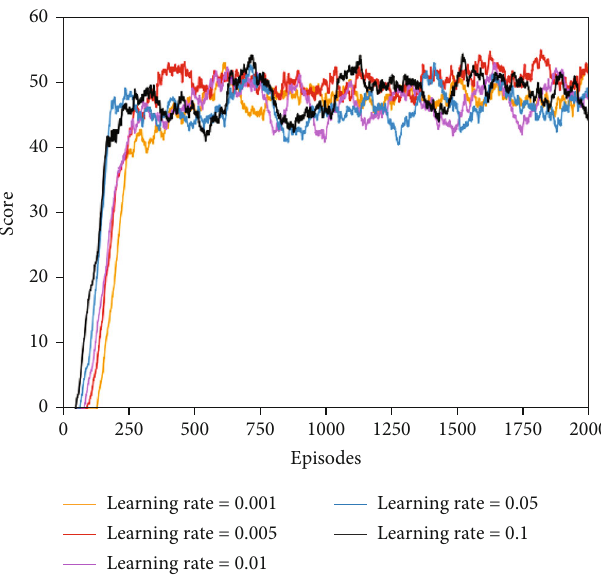
Figure 5: The score with di ff erent learning rates.